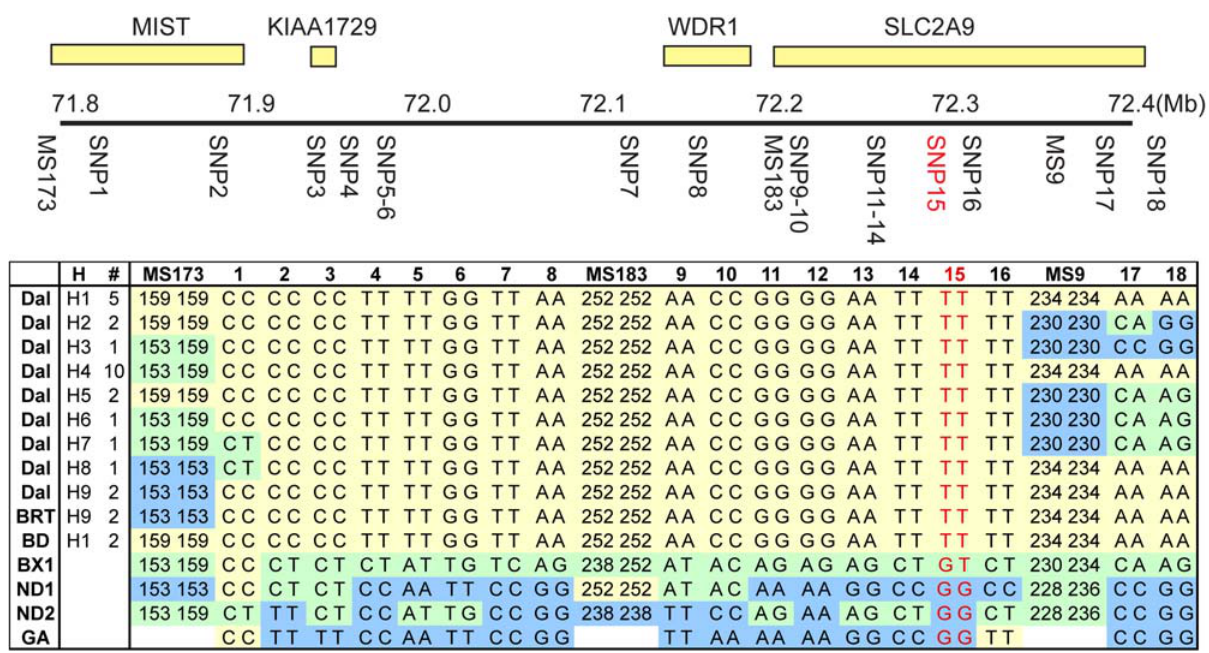
Figure 3. Homozygosity mapping of the huu locus. The four genes located in this interval are presented at the top of the figure. A region of CFA03 with distances in Mb above the line and marker locations below the line are shown. Genotypes across this region are shown in the boxed area. The breed is listed in the first column using the following abbreviations: Dal, Dalmatian; BRT, Black Russian Terrier; BD, Bulldog; BX1, heterozygous backcross dog; ND1 and ND2, mixed breed dogs; GA, genome assembly Boxer sequence. The different haplotypes are named in the second column, and the number of times that they were observed is shown in the third column. SNP15, shown in red, is the candidate causal mutation in exon 5 of SLC2A9. SNP9 and SNP10 are the promoter mutations in variant O. The common Dalmatian haplotype is shown in yellow, the non-Dalmatian genotype is shown in blue, and heterozygous genotypes are shown in green. Microsatellite allele sizes are absent for the genome assembly Boxer (GA) since DNA was not available for direct testing of the microsatellites.